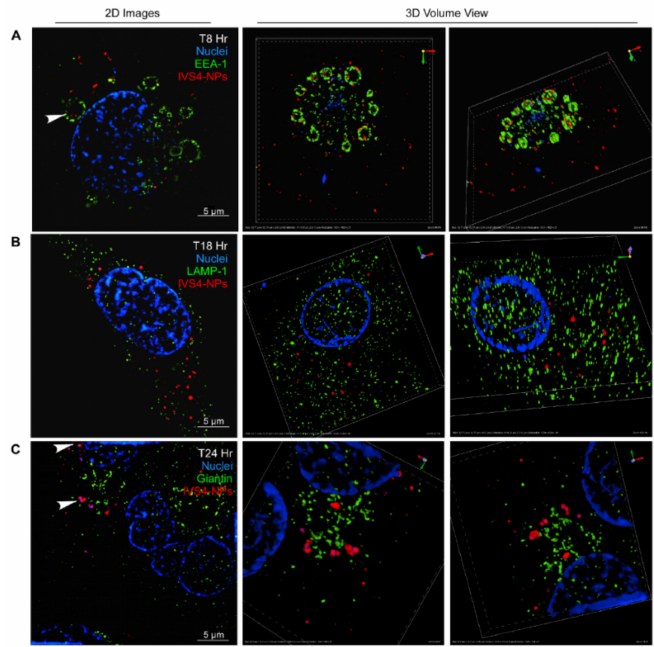
Figure 4. IVS4-Cy3-HGC NPs are endocytosed to the early endosome and then to the Golgi apparatus. ( A ) The IVS4-Cy3-HGC NPs (red channel) appeared to be entrapped within the spherical structure of the early endosome (green channel) after 8 h of incubation (top panel). ( B ) While the lysosome (green channel) is typically the next compartment encountered during endocytosis, no co-localization with the NPs was observed at any time point (middle panel). ( C ) Instead, the NPs appeared to be enmeshed within the structure of the Golgi apparatus (green channel) 24 h post delivery (bottom